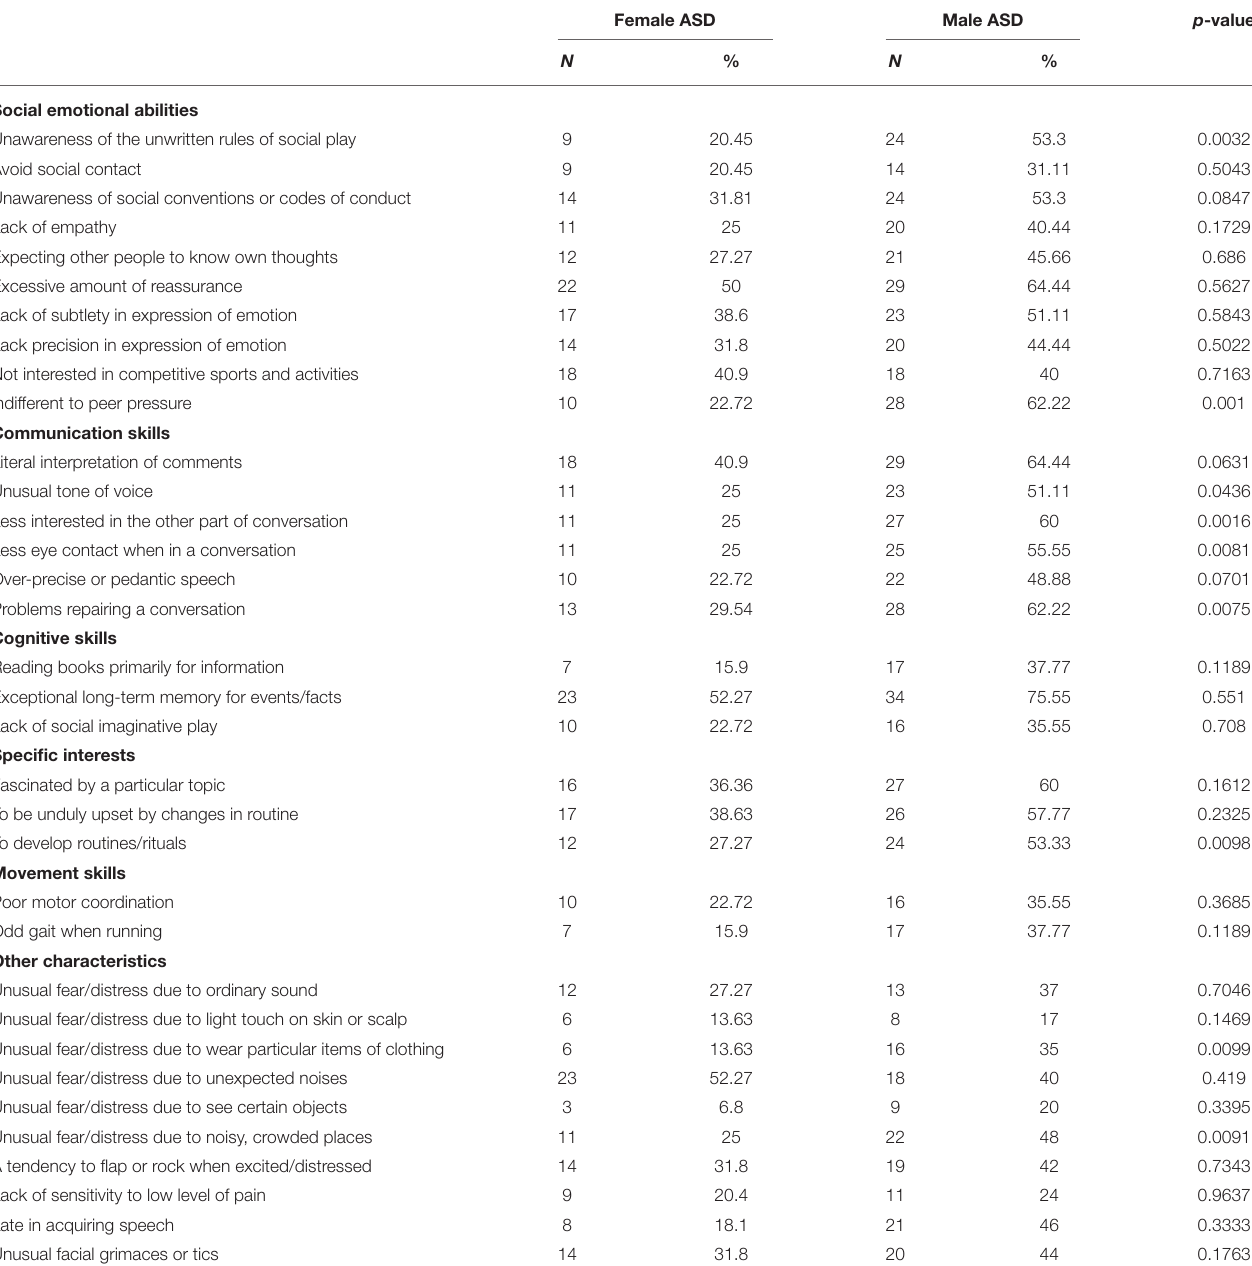
TABLE 5 | Core clinical features obtained from ASAS.